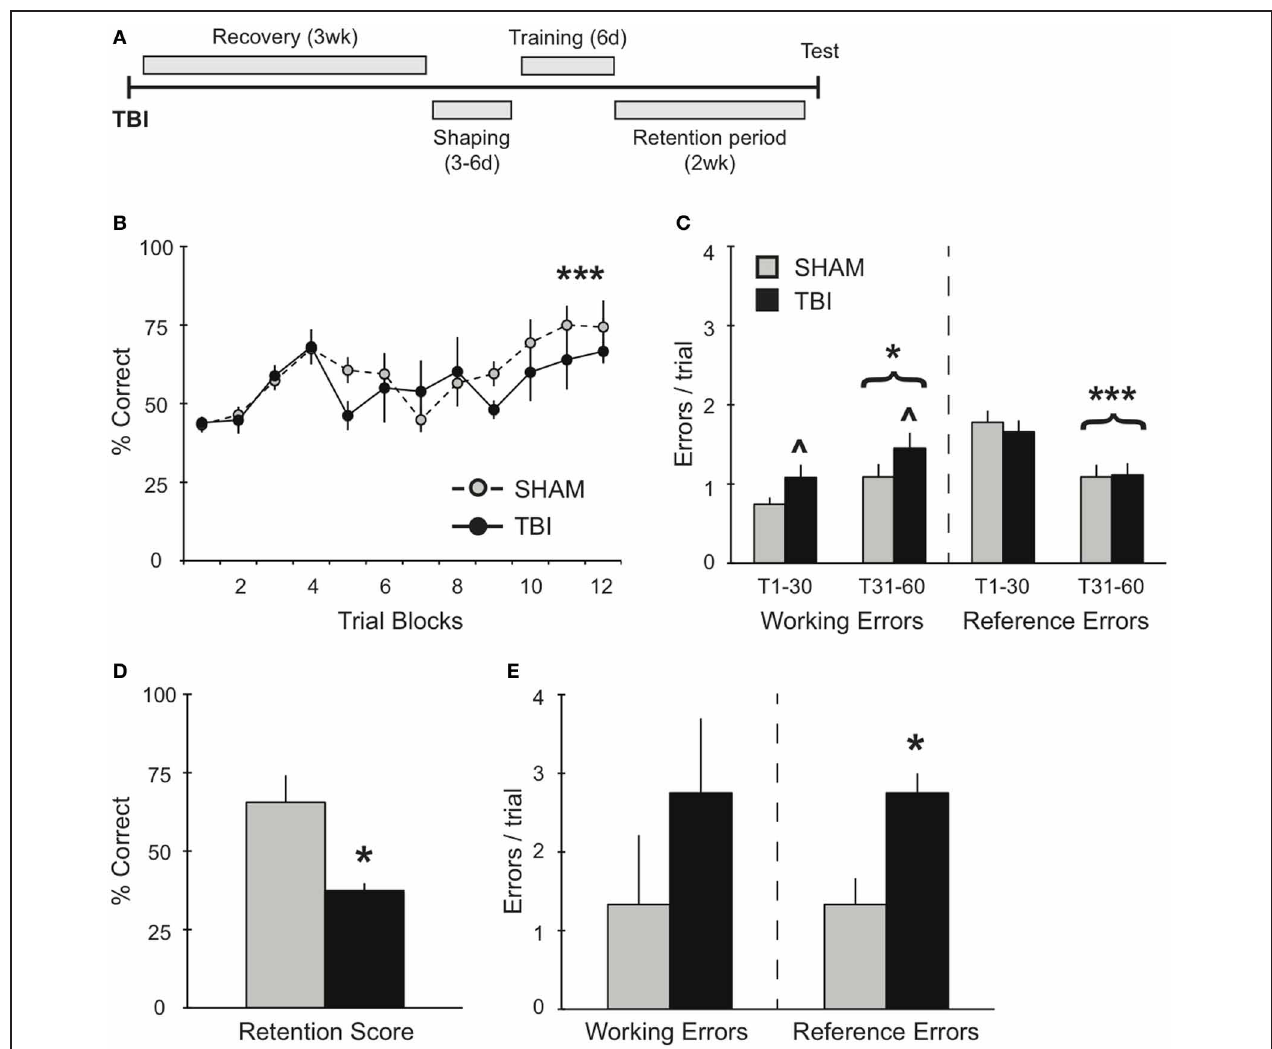
FIGURE 2 | TBI induces differential memory deficits during training and retention testing 3 weeks post-injury. (A) Schematic diagram of the experimental design and timeline for experiment 2. (B,C) During training, there was a significant improvement in percent correct and a significant decrease in reference errors across training days for both groups